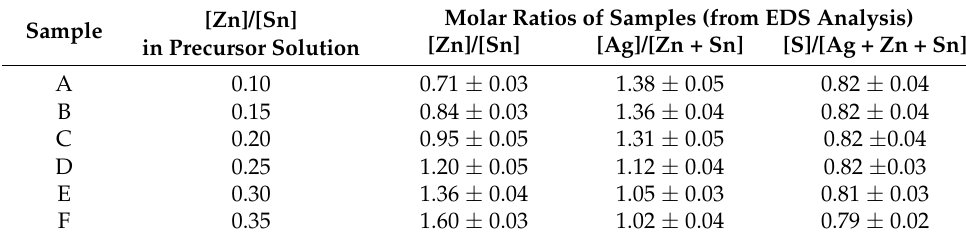
Table 1. Molar ratios of samples obtained from EDS analysis.